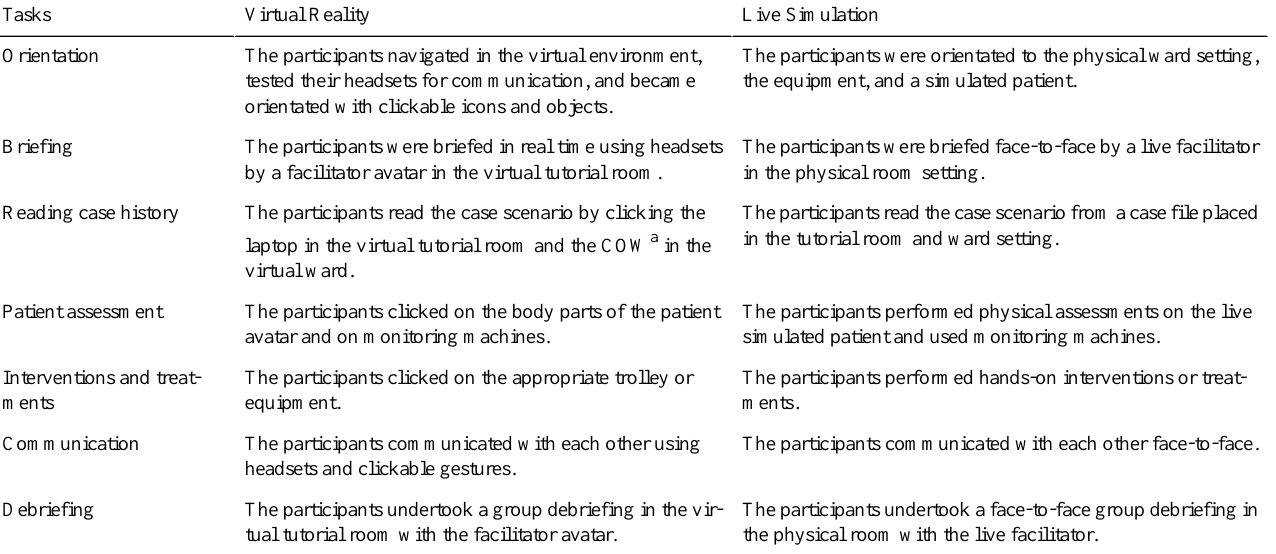
Table 1. Comparison of tasks performed by the participants in virtual reality and live simulations.